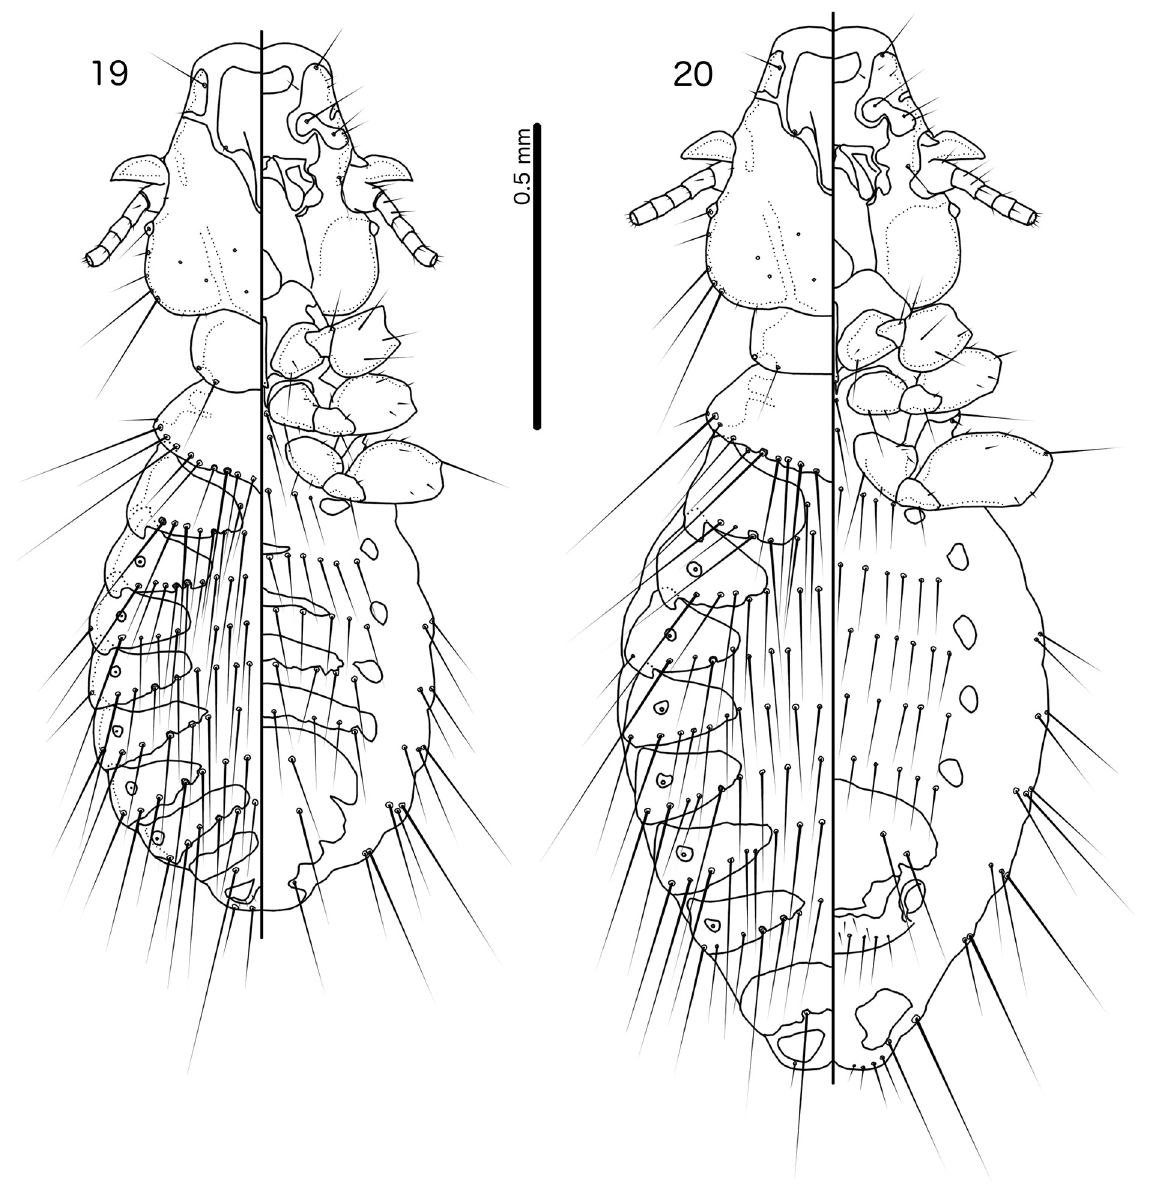
Figs 19–20. Philopterus sinensis sp. nov. ex Hemipus picatus capitalis (Horsfield, 1840). 19 . Male habitus, dorsal and ventral views. 20 . Female habitus, dorsal and ventral